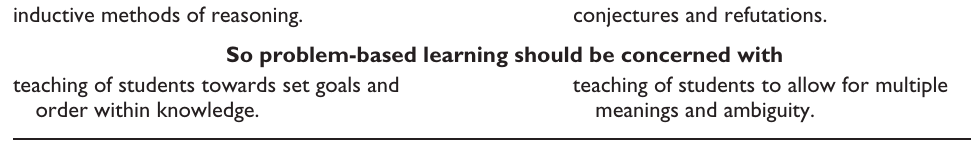
conjectures and